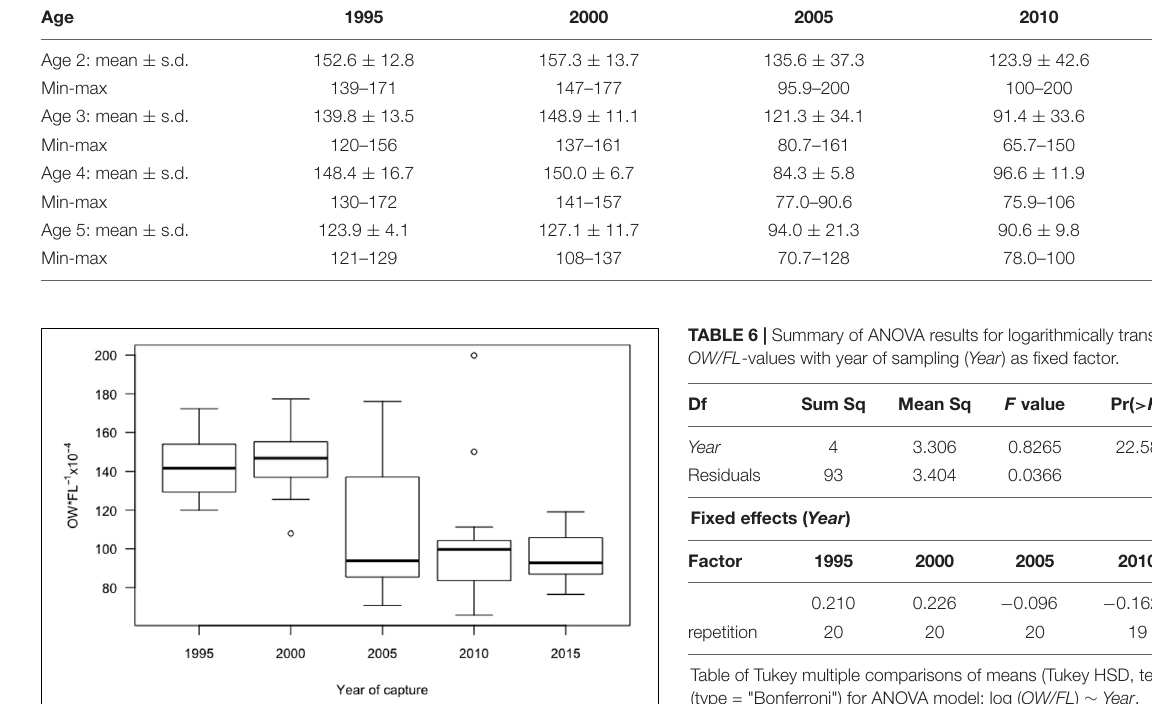
FIGURE 8 | Boxplot of the otolith width ( µ m) in relation to fish length (cm) for all cod included in the study. Boxplots show median, interquartile ranges (box), ranges (vertical lines) and outliers (points).